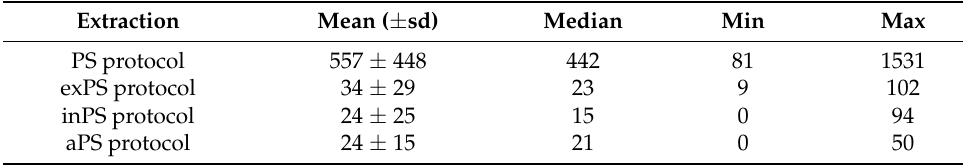
Table A5. DNA quantification in ng.g sed − 1